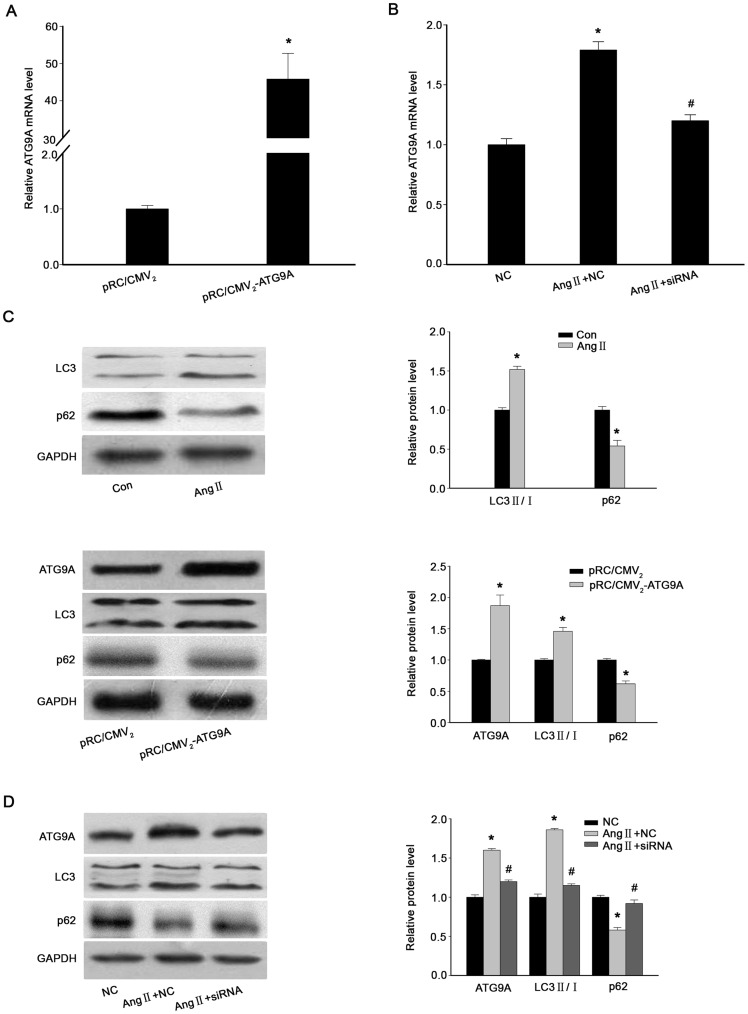
Effect of ATG9A expression on regulation of autophagy-activated marker protein levels in cardiomyocytes.(A) qRT-PCR. The cardiomyocytes were transfected with ATG9A cDNA or vector control and then subjected to qRT-PCR analysis of AGT9A mRNA. *P<0.05 compared with vector Control. (B) qRT-PCR. The cardiomyocytes were treated with negative control lentivirus or Ang II plus ATG9A siRNA or plus negative control lentivirus and then subjected to qRT-PCR analysis of AGT9A mRNA. *P<0.05 compared with negative Control; #P<0.05 compared with Ang II + NC. (C) Western blot. The cardiomyocytes were treated with 1 µmol/L Ang II or control (Con) or transfected with ATG9A cDNA or vector control and then subjected to Western blot. *P<0.05 compared with Control. (D) Western blot. The cardiomyocytes were treated with negative control lentivirus or Ang II plus ATG9A siRNA or plus negative control lentivirus and then subjected to Western blot. *P<0.05 compared with negative Control; #P<0.05 compared with Ang II + NC. The graphs are quantified data from the Western blots.